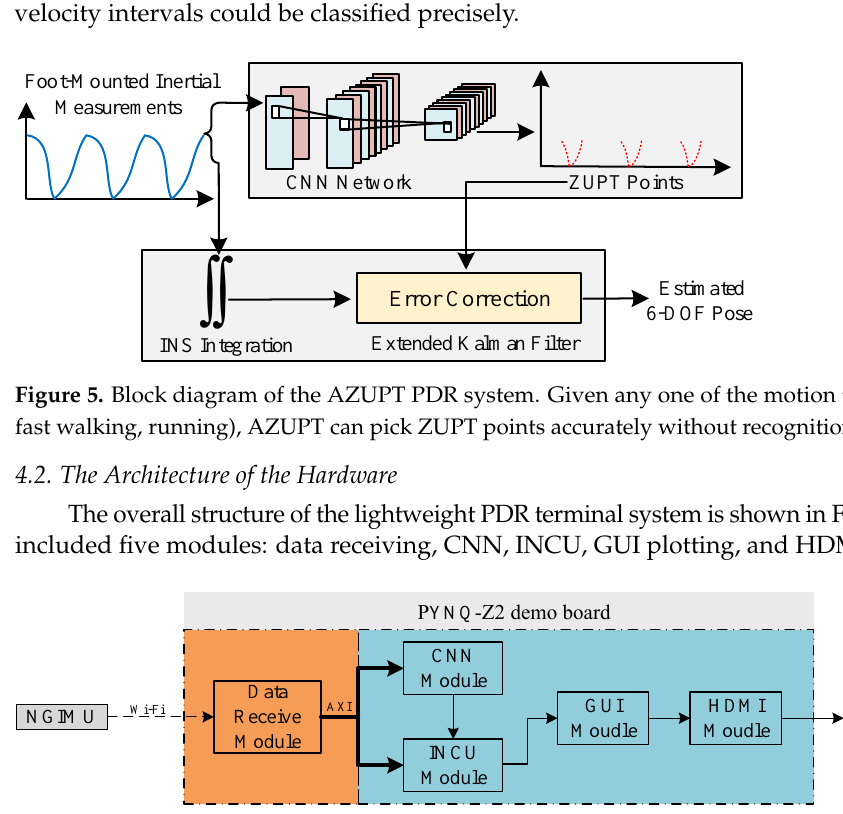
Figure 6. System architecture of the real-time PDR terminal